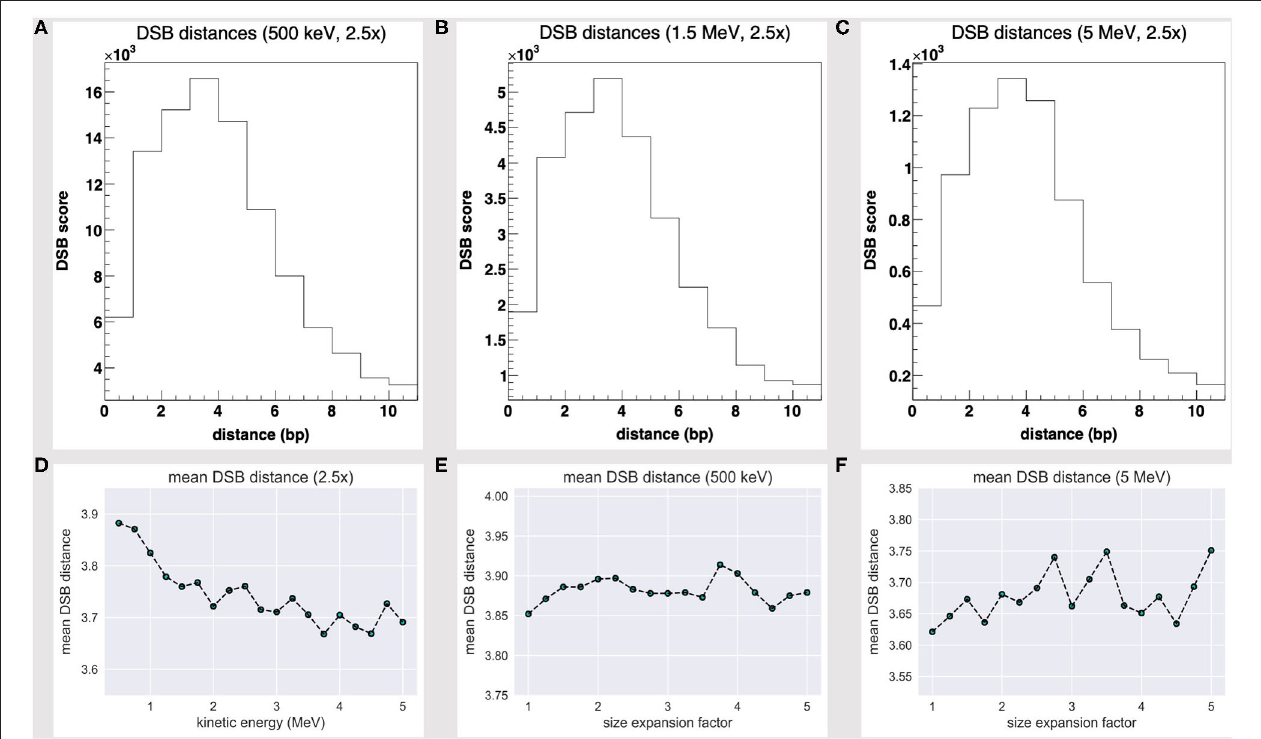
FIGURE 4 | DSB distance scores at fixed 2.5-fold linear size expansion, at (A) 500 keV, (B) 1.5 MeV, and (C) 5 MeV; all share a Poisson fit and are biased towards short-distanced DSBs. The DSB distance mean score at a fixed 2.5-fold size expansion (D) shows a slight decrease with the particle energy and fluctuates as the water box is expanded at (E) 500 keV and (F) 5